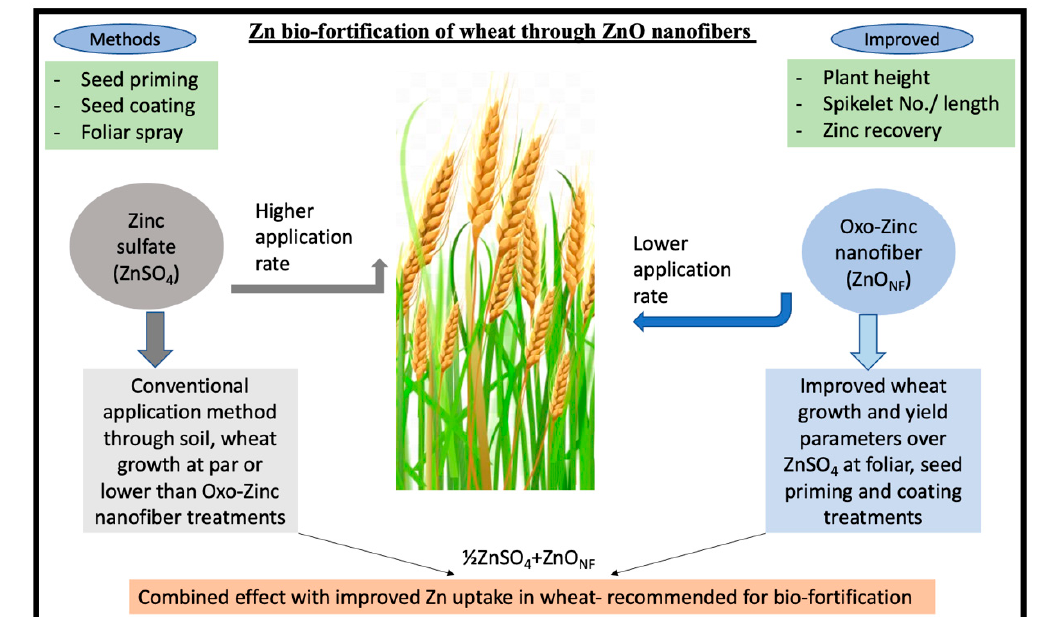
Figure 4. Graphical presentation of increased wheat production and Zn biofortification in wheat.